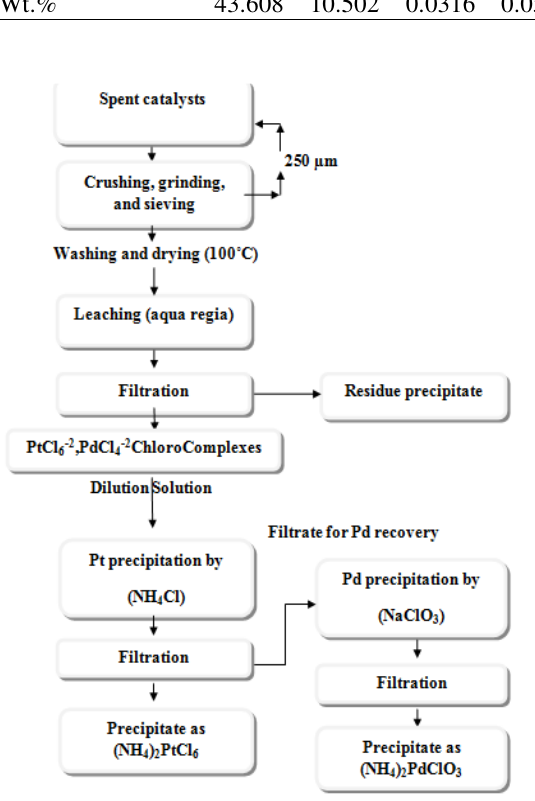
Fig. 3. Flow chart for recovery of Pt, Pd from spent catalytic converter.